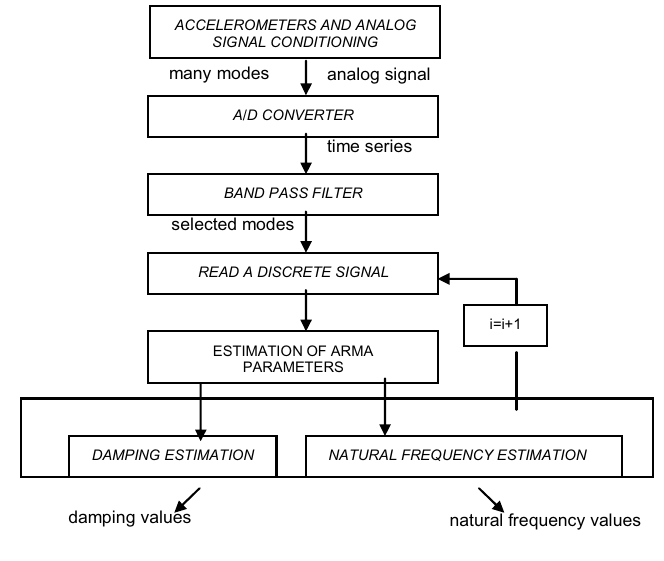
Fig. 1. Flowchart of recursive method for damping